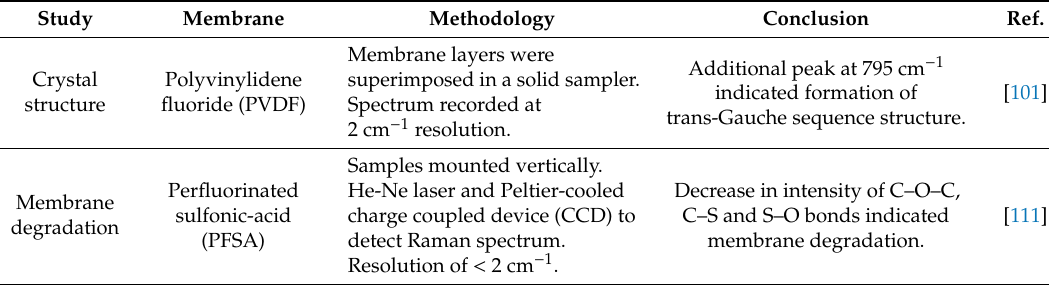
Figure 24. Functional groups identified by Raman spectroscopy and the corresponding wavelength [110]. Table 8. Raman studies for characterization of polymeric membrane.